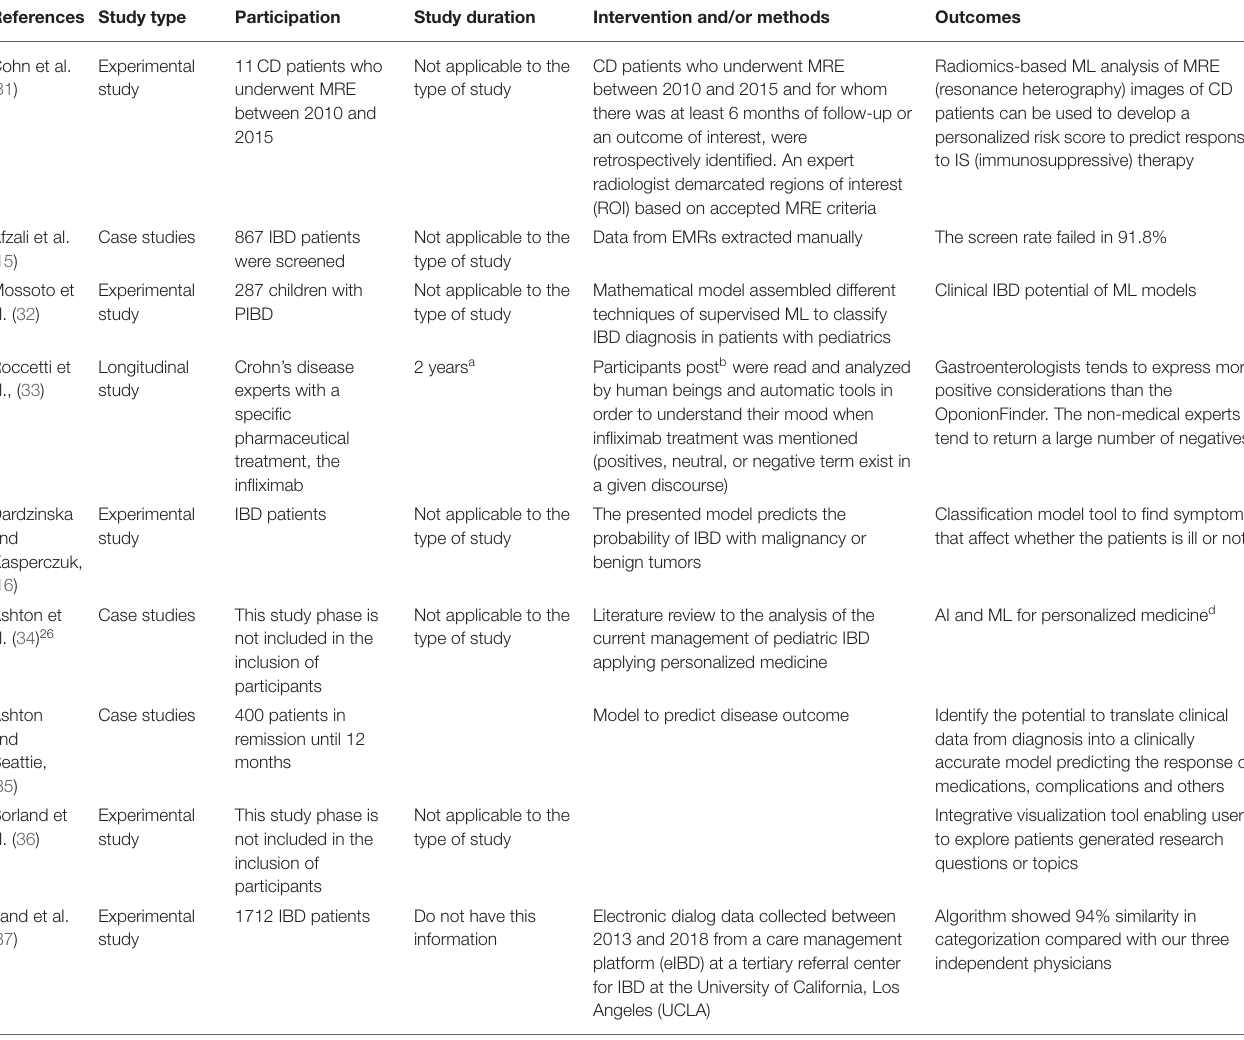
TABLE 3 | Literature map of the included